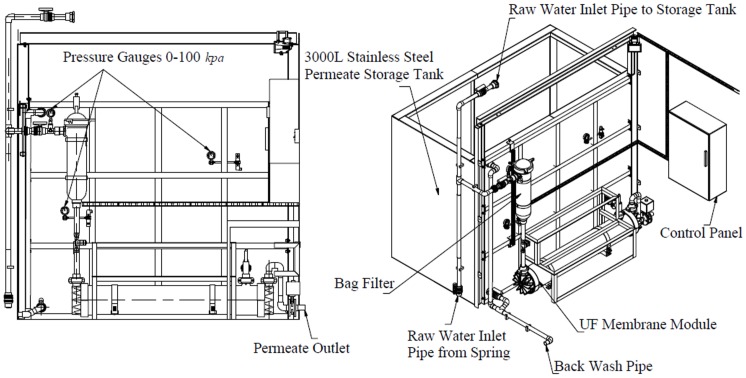
Internal design of the pilot plant in Tshaanda.